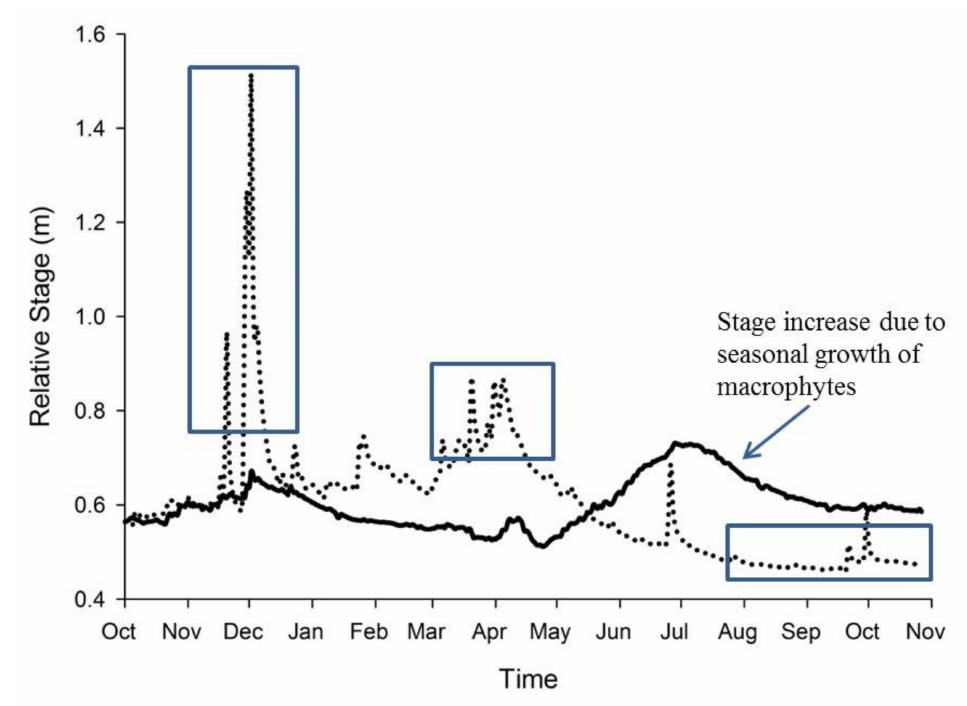
Figure 4. Comparison of stage fluctuations on a volcanic spring-fed river (solid line) and a runoff river (dotted line) in northern California, USA. Rectangles indicate typically stressful periods for fish with high discharge events occurring during the winter and spring, and low flow periods during the late summer and fall. (Adapted from [15]).